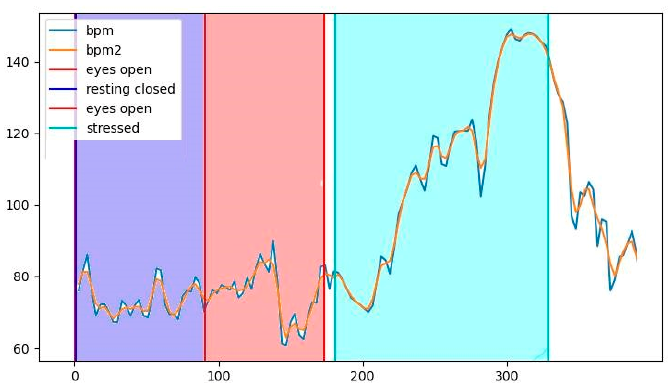
Figure 4. BPM signal of a subject across the experiment. Magenta represents the resting state, red represents the calm state, and light blue represents the stressed state.